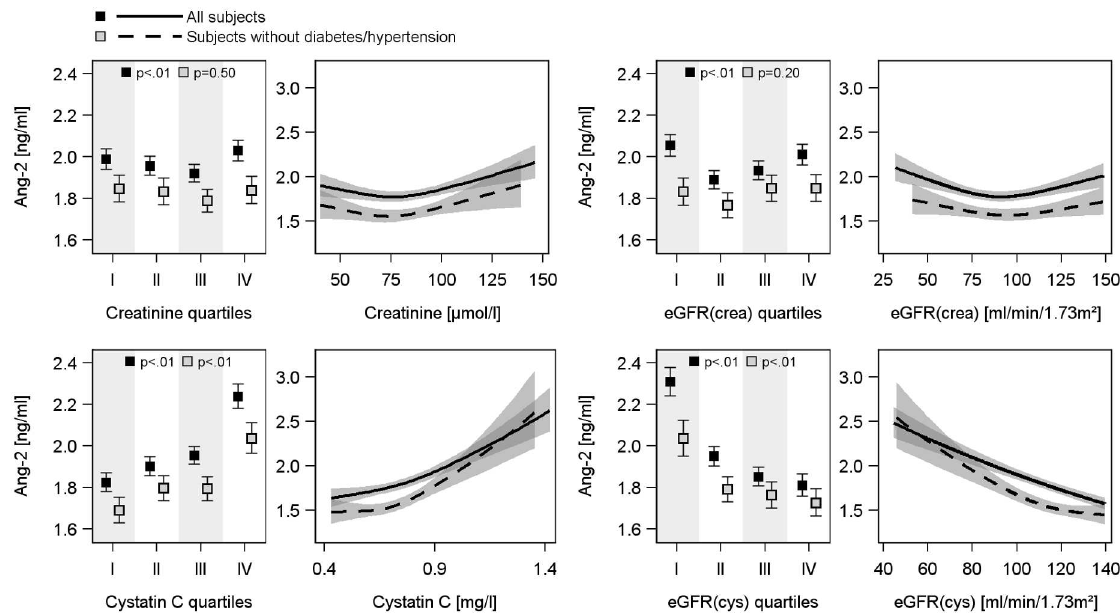
Fig 3. Associations between serum creatinine concentration, creatinine-based estimated glomerular filtration rate [eGFR(crea)], serum cystatin C concentration or cystatin C-based eGFR [eGFR(cys)] and serum angiopoietin-2 (Ang-2) concentration in the SHIP-Trend population. For each exposure left side: Estimated mean serum Ang-2 with 95% confidence intervals (CI) by sex-specificquartilesof exposurecalculatedby analysisof variance adjustedfor age, sex and waist circumference. Right side: linear regression line with 95% CI (grey shadedarea). Linearregressionmodels with restricted cubic splines were adjusted for age, sex, waist circumference, smoking,total cholesterol, systolic and diastolicblood pressureand additionallyin the wholepopulationfor diabetesmellitus type 2 and use of antihypertensive medication.